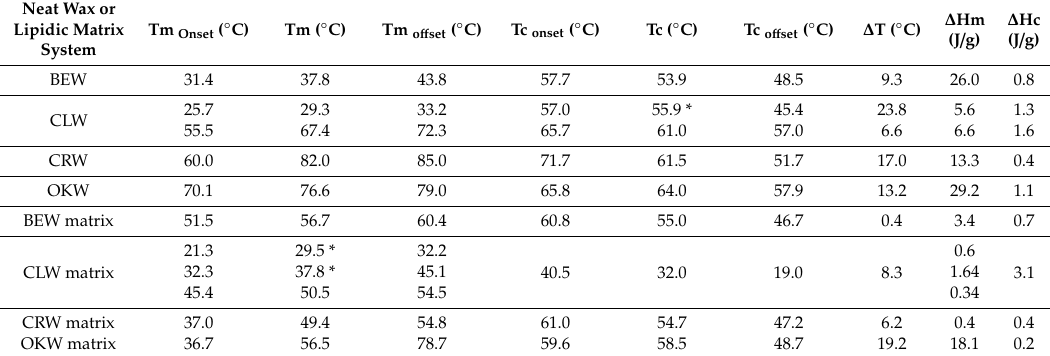
Table 2. Thermal parameters obtained from the DSC